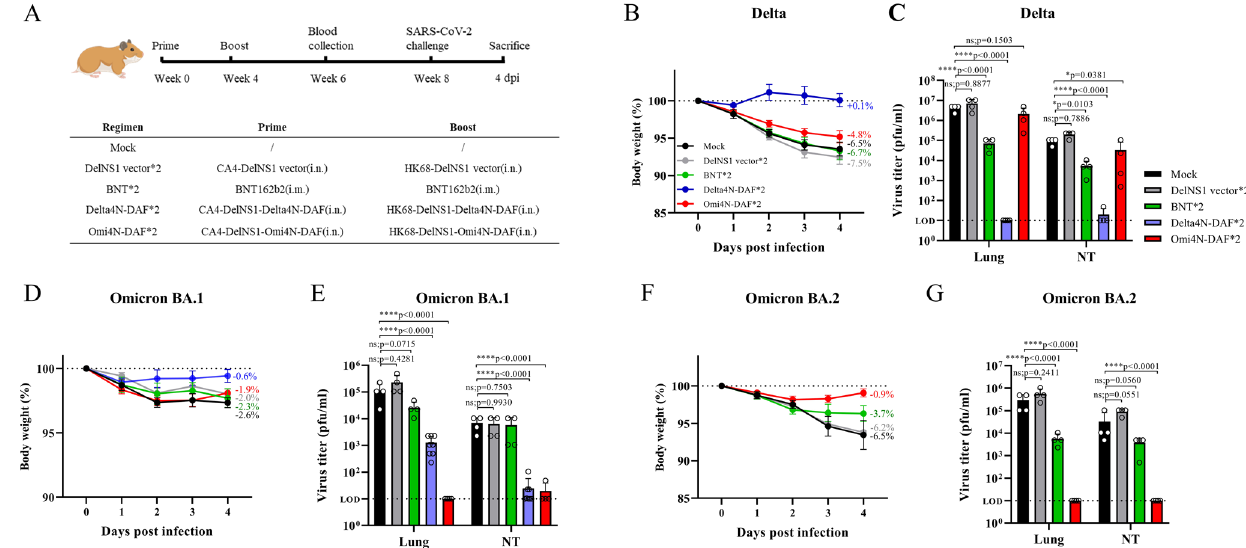
Fig. 5 | Protection against SARS-CoV-2 virus challenge in hamsters through prime-boost immunization with BNT162b2 mRNA or DelNS1-RBD4N-DAF vac- cines.A Illustrationofscheduleofimmunization,bloodcollectionandSARS-CoV-2 virus challenge for hamsters. Hamsters were prime-boost vaccinated either intra- nasally with Delta4N-DAF (5×10 6 pfu), Omi4N-DAF (5×10 6 pfu), DelNS1 vector (5×10 6 pfu) or PBS (mock) or intramuscularly with BNT162b2 mRNA (1/6 clinical dose (5ug)) vaccine. Hamsters were challenged with SARS-CoV-2 variants Delta or Omicron BA.2 at 1×10 4 pfu per hamster, 4 weeks after boost immunization. Body